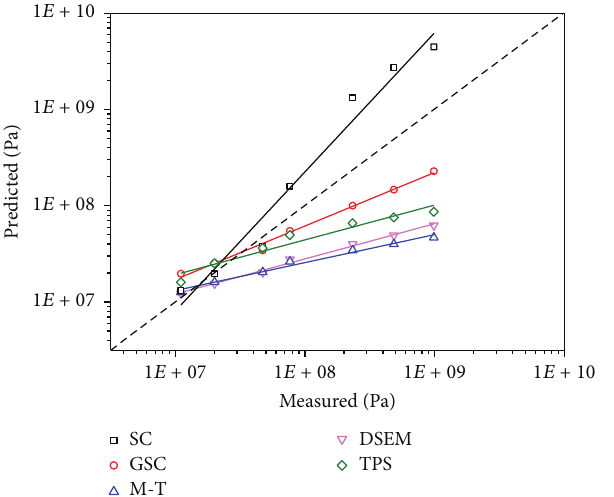
Figure 10: Effect of modulus mismatch on the prediction